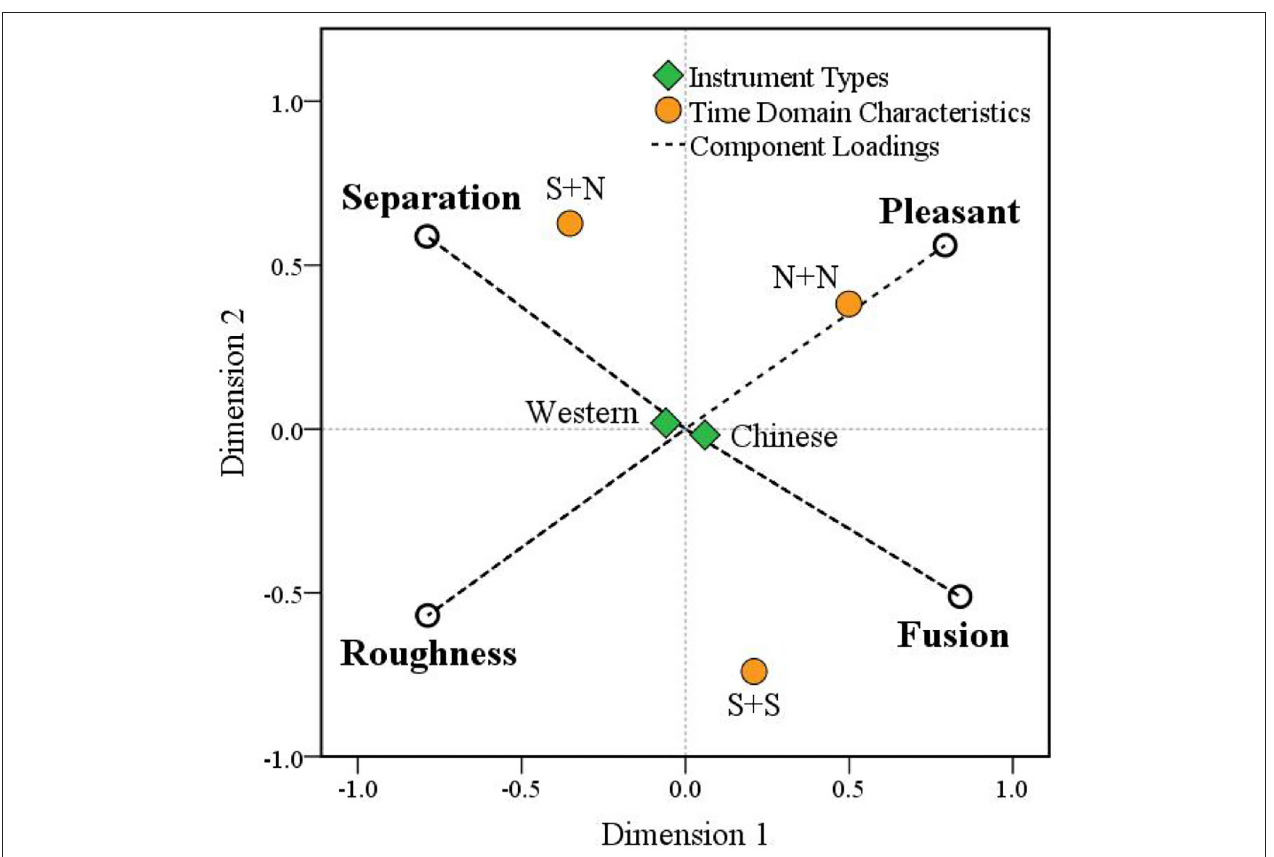
FIGURE 16 | A preference space location